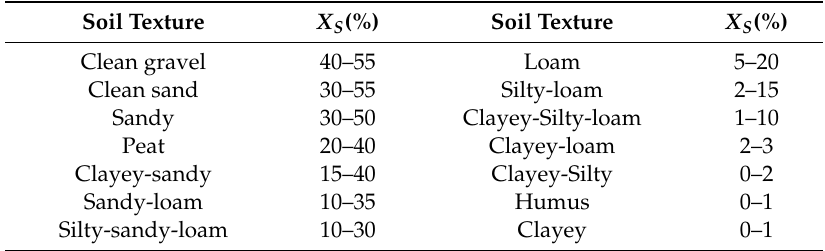
Table 2. Main textural classes of soils and relative potential infiltration coe ffi cients